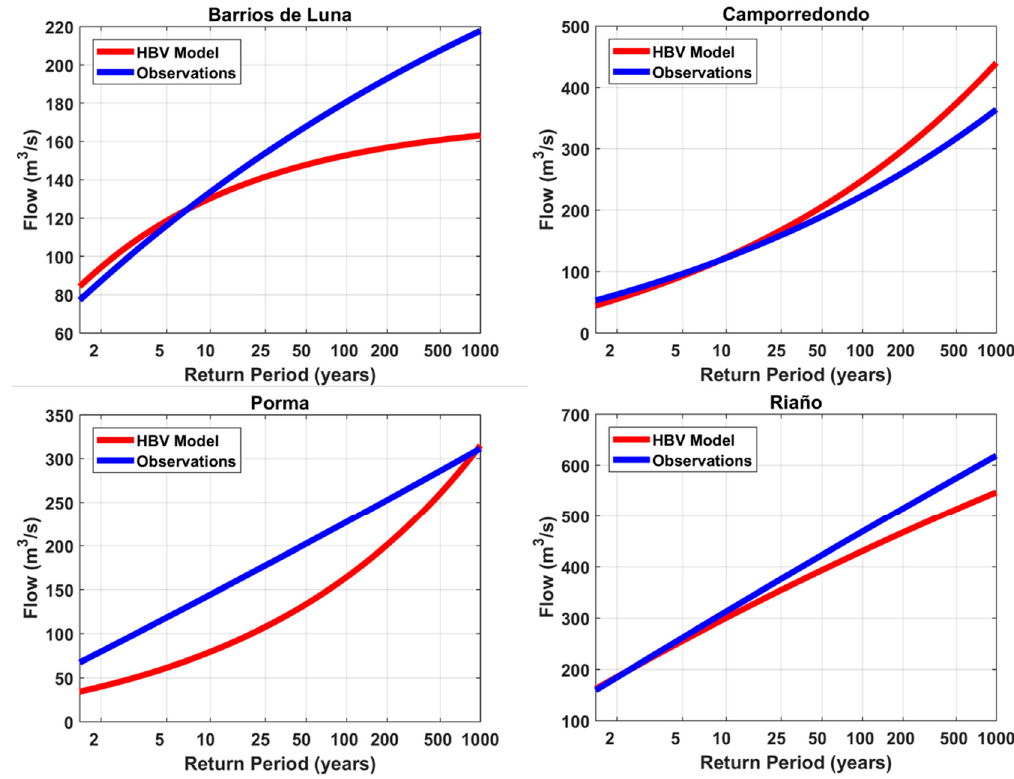
Figure 2. Comparison between HBV results and observations in the control period.